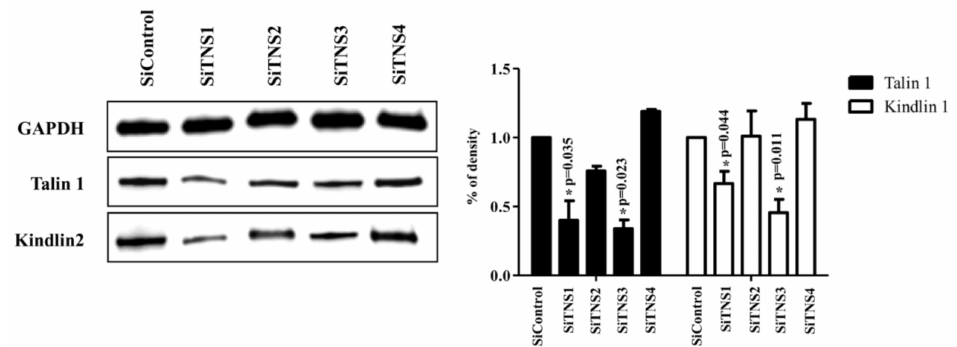
Figure 7. TNS1 and TNS3 interact with talin1 and kindlin2 in focal adhesion of tonsil mesenchymal stem cells (TMSCs). Western blotting analysis suggested that talin1 and kindlin2 were significantly decreased in siTNS1- and siTNS3-treated cells. In contrast, transfection with siTNS4 led to a slight increase in talin1 and kindlin2 levels. * p < 0.05, compared to siControl. n = 4. Columns and error bars represent mean ± standard